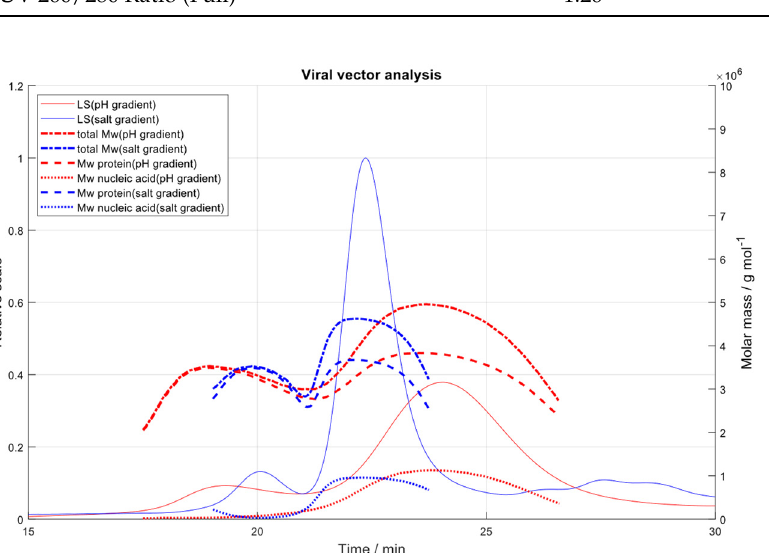
Figure 7. Overlay of the LS chromatograms and “viral vector analysis” of AAV8 obtained by a linear pH gradient (red) or linear salt gradient